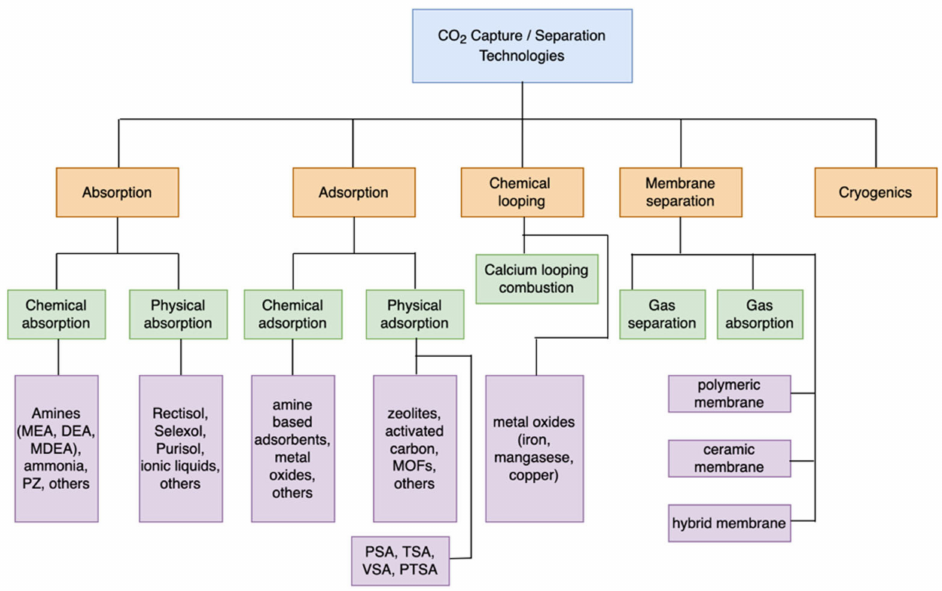
Figure 2. Separation techniques for CO 2 capture